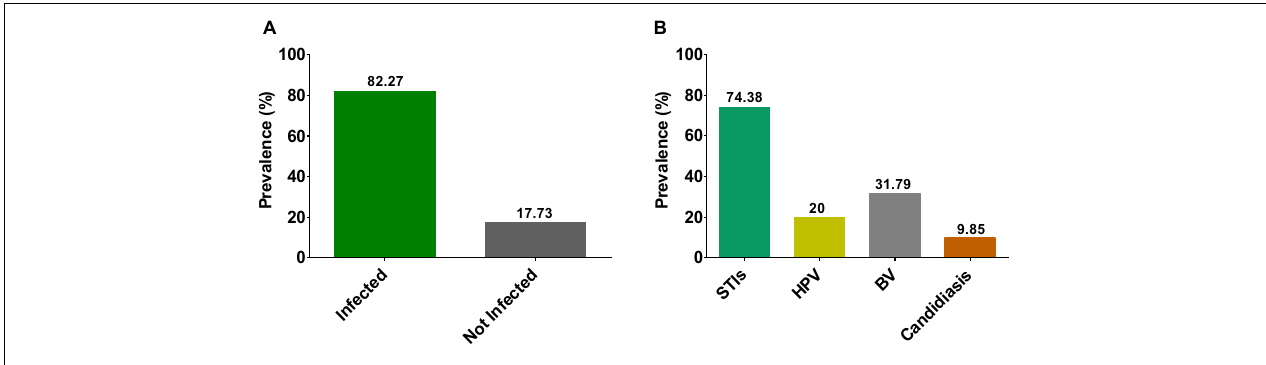
FIGURE 1 | Prevalence of FRTIs. The bars indicate the prevalence of infected and non-infected (A) ; and sexually transmitted infections (STI without HPV), human papilloma virus (HPV), bacterial vaginosis (BV), and candidiasis (B)